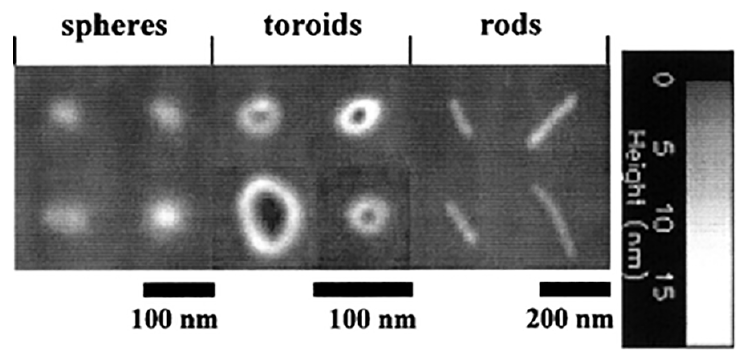
Figure 3. Spherical, toroidal and rod shapes of polyplexes base on fractionated chitosan oligomers. The polyplexes were formed at a concentration 13.3 µg/mL and a charge ratio of 60:1 and examined in the atomic force microscope. The horizontal bars indicate 100 nm (spheres and toroids) and 200 nm (rods). The vertical bar gives the height of the polyplexes. Reproduced from [22] with permission from